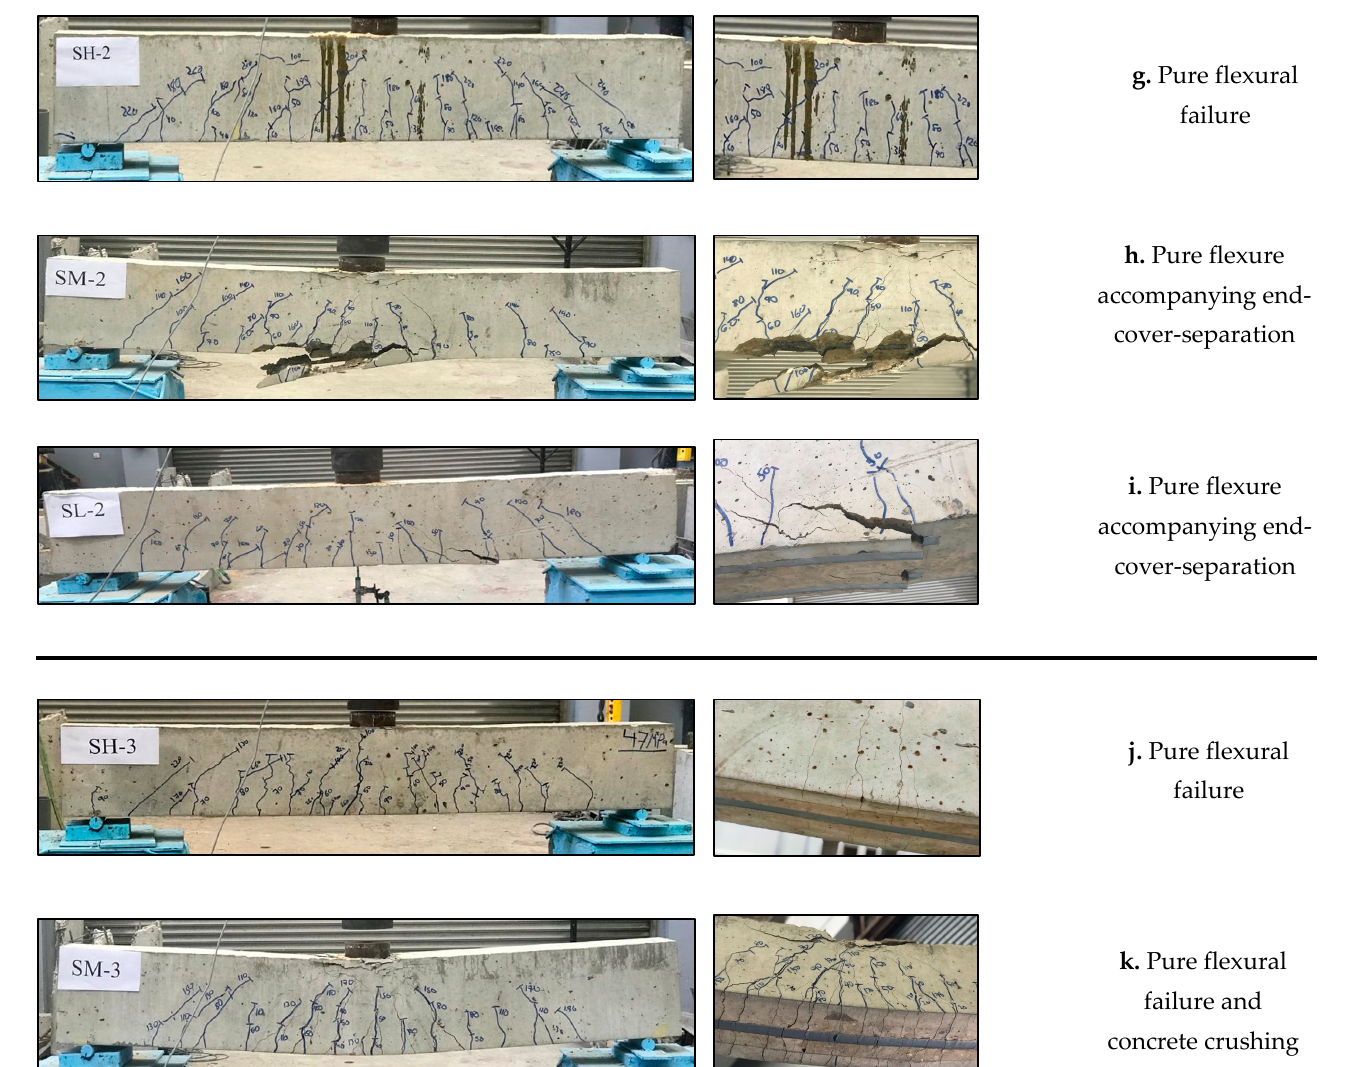
Figure 9. Failure modes of all specimens.